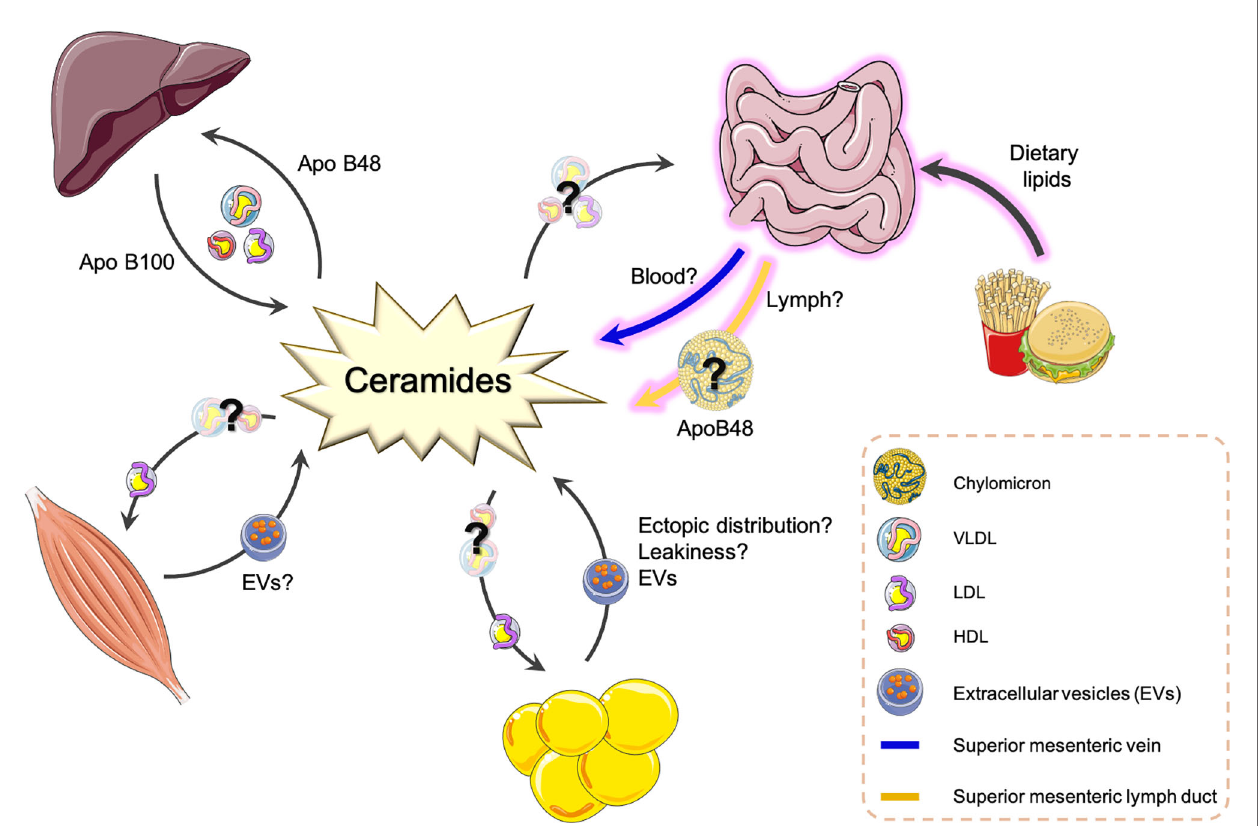
FIGURE 2 | Potential origins and transport routes of ceramide species around the body. This is a summary of known transport routes and packaging systems of ceramide species as determined from the current literature. Question marks and broken line arrows are suggestive of new routes and transport routes mechanisms that have recently been proposed or published. ApoB, Apolipoprotein protein; EV, Extracellular vesicle; LDL, low density lipoprotein; VLDL, very low-density lipoprotein; HDL, high density